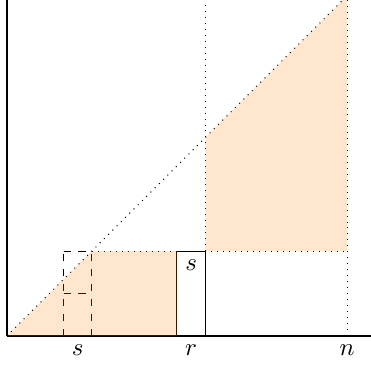
Figure 1: Sketch indicating an alphabetic point s in position r in an inversion sequence.